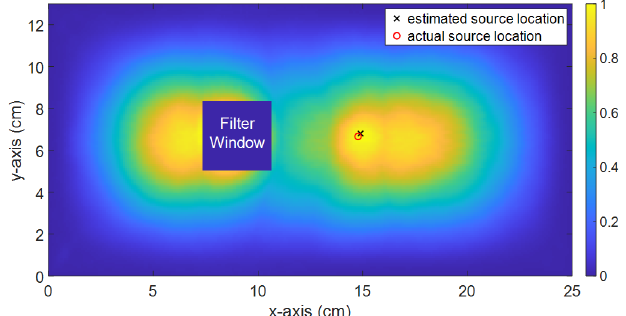
Figure 5. Distribution of the normalized maximum power at the z = 1 cm cut plane in absence of the transmitter monopole antenna in the backward propagation step. The black cross shows the global maximum power, which occurs on the z = 1 cm cut plane. The red circle is the intersection between the z = 1 cm cut plane and the monopole antenna. The estimated location error, defined as the two-dimensional distance between the red circle and the black cross, is 0.18 cm. If the error is measured as the three-dimensional distance from the black cross to the antenna feeding point, it equals 1.02 cm. The blue square with side length of 16 cells (3.4 cm) at the location of the sensor shows the mask filter that was used in this simulation.